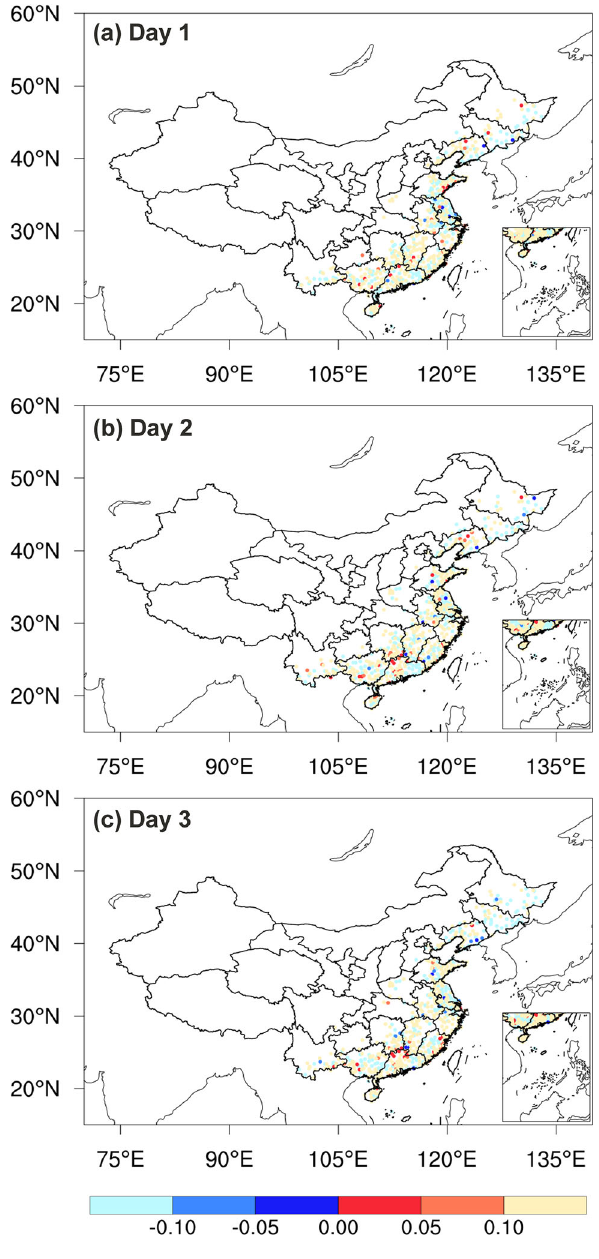
Fig. 5 Spatial distributions of trends in tropical cyclone (TC)- induced annual maximum (AM) Day 1 ( a ), Day 2 ( b ), and Day 3 ( c ) precipitation in the mainland of China. The trends were detected by the Mann–Kendall method and the values in each panel indicate the corresponding significance p values. The red (blue) p values indicate positive (negative) trends in TC-induced AM